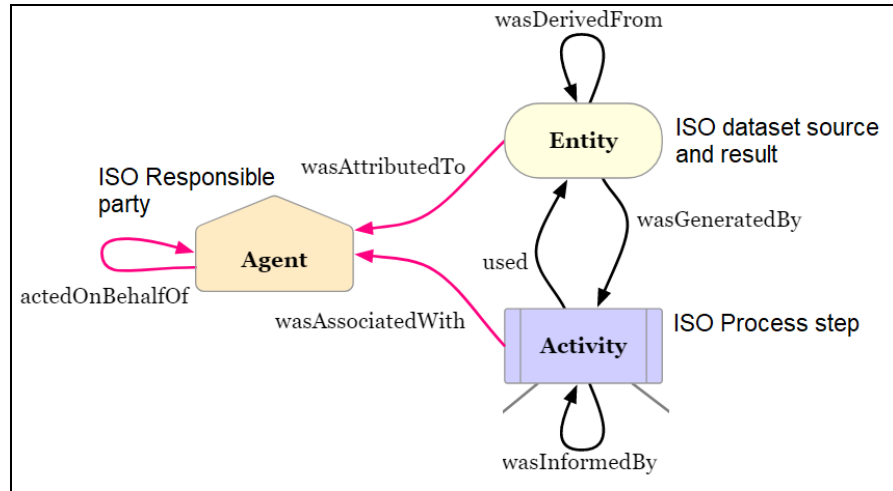
Figure 2. The three Starting Point classes in PROV mapped to International Organization for Standardization (ISO) classes for lineage. PROV properties that relate them emerge (from the PROV ontology modified). Table 2. W3C PROV relationships and the ISO classes that they connect. W3C PROV Relationships ISO 19115 Classes